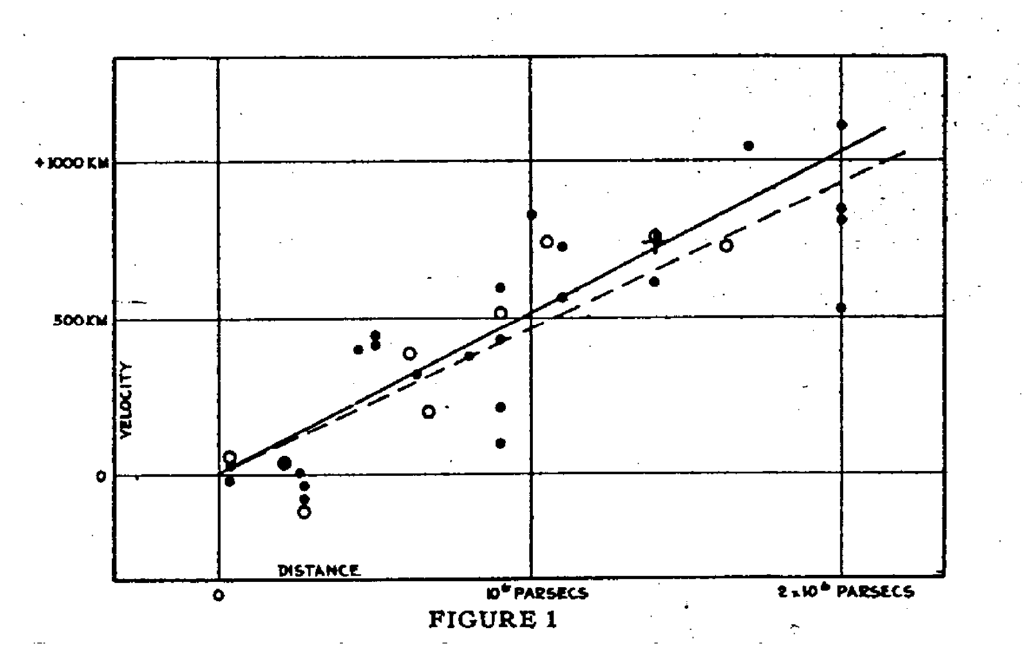
Figure 5. Hubble’s velocity-distance diagram from 1929.